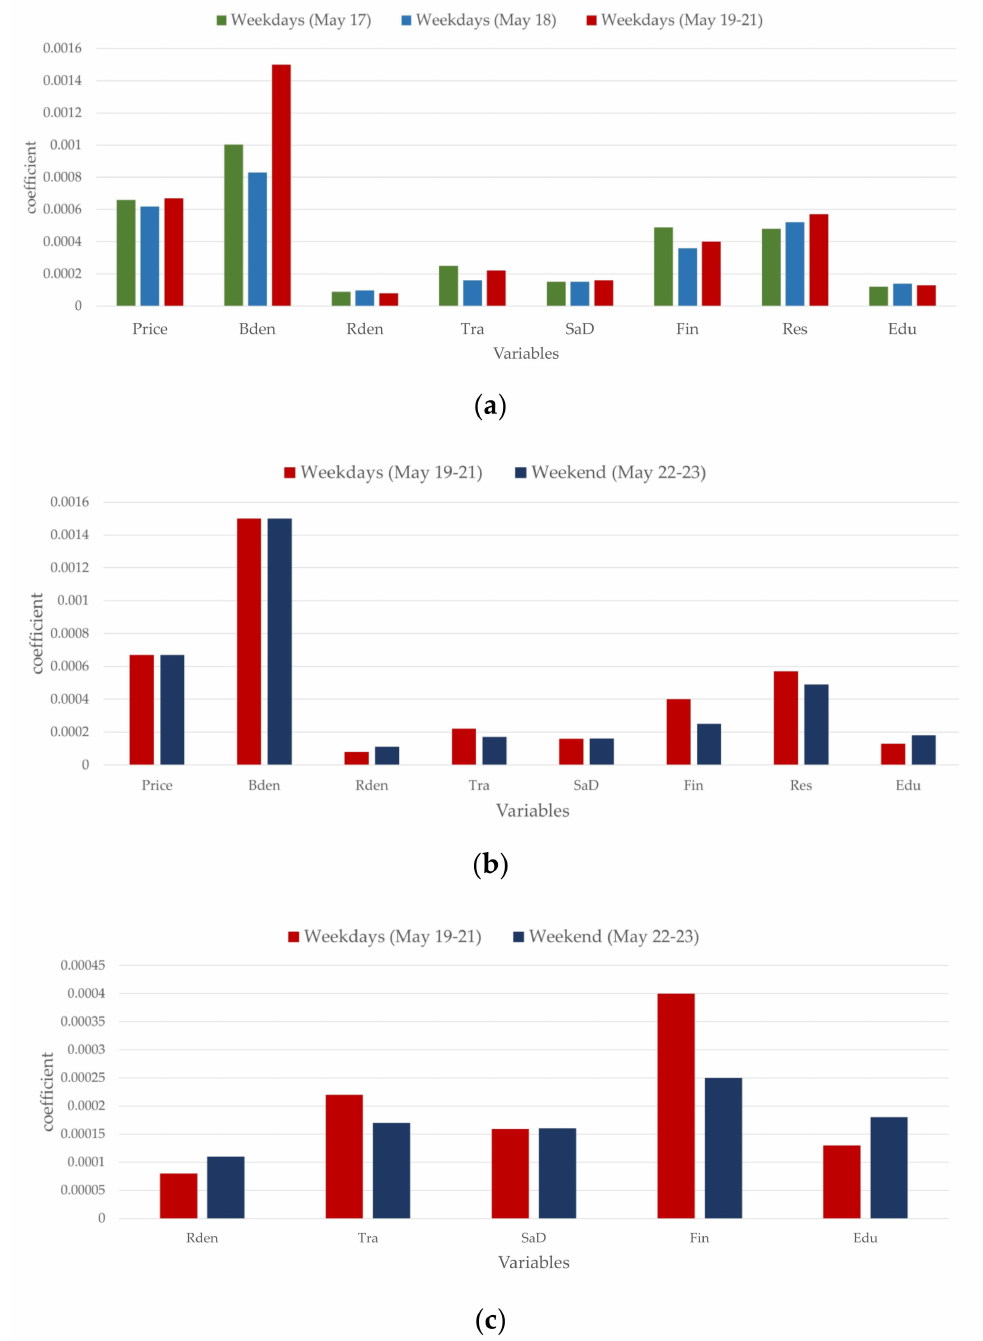
Figure 7. ERGM estimation results: ( a ) Coefficient values of all the influencing factors on week- days; ( b ) Comparison of coefficient values of all influencing factors on weekdays and weekends; ( c ) Coefficient values of influencing factors other than Price, Bden and